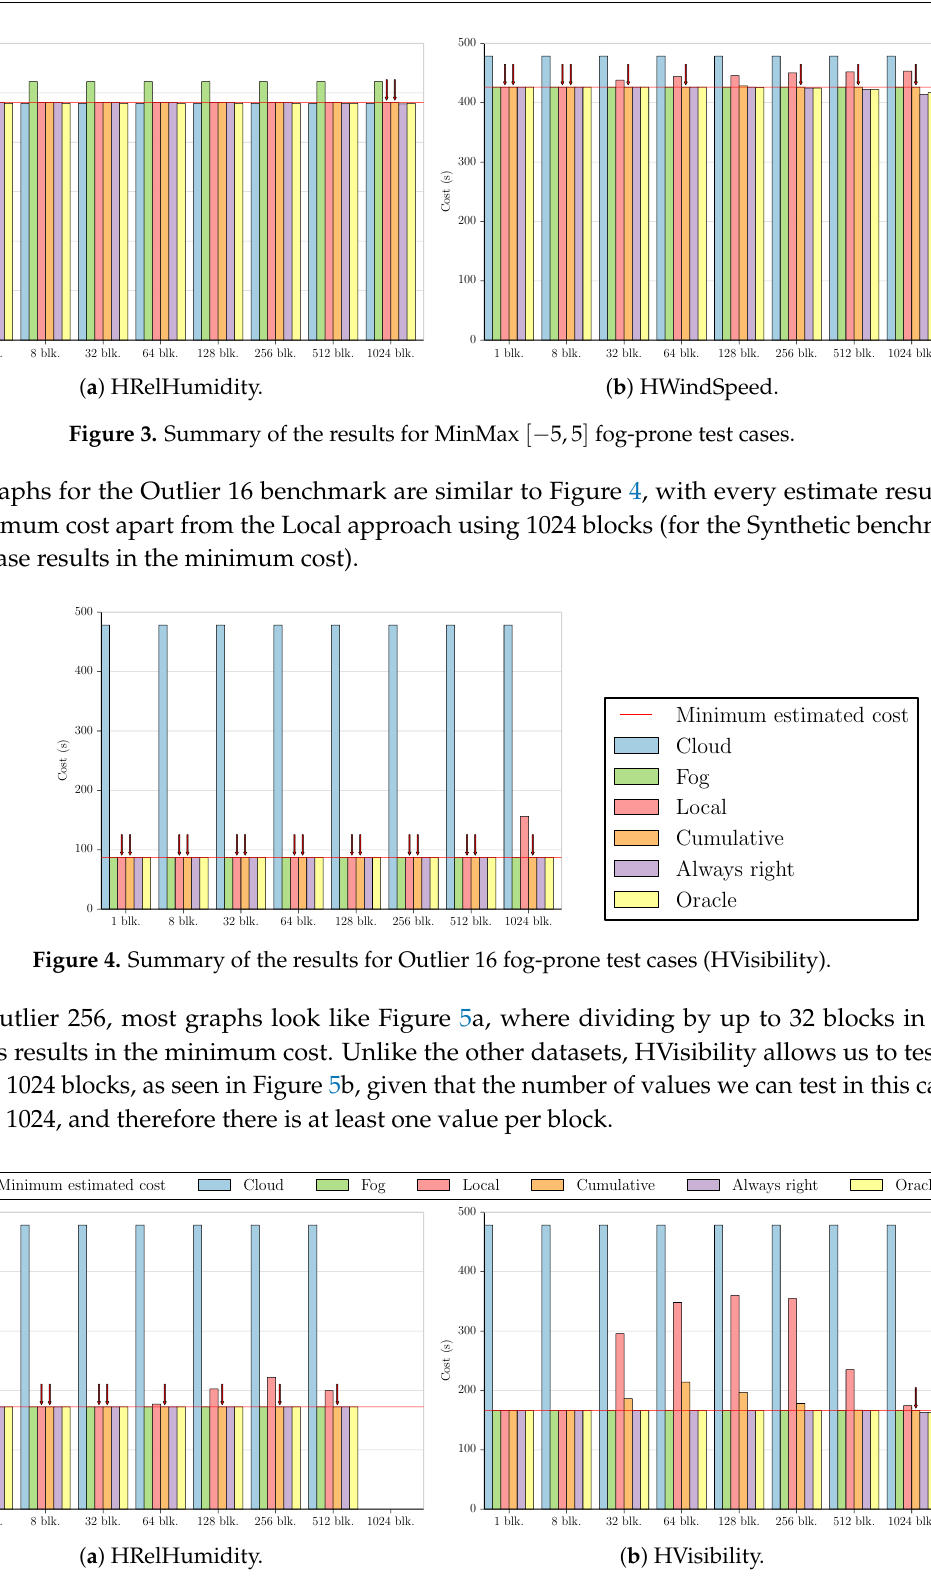
Figure 5. Summary of the results for Outlier 256 fog-prone test